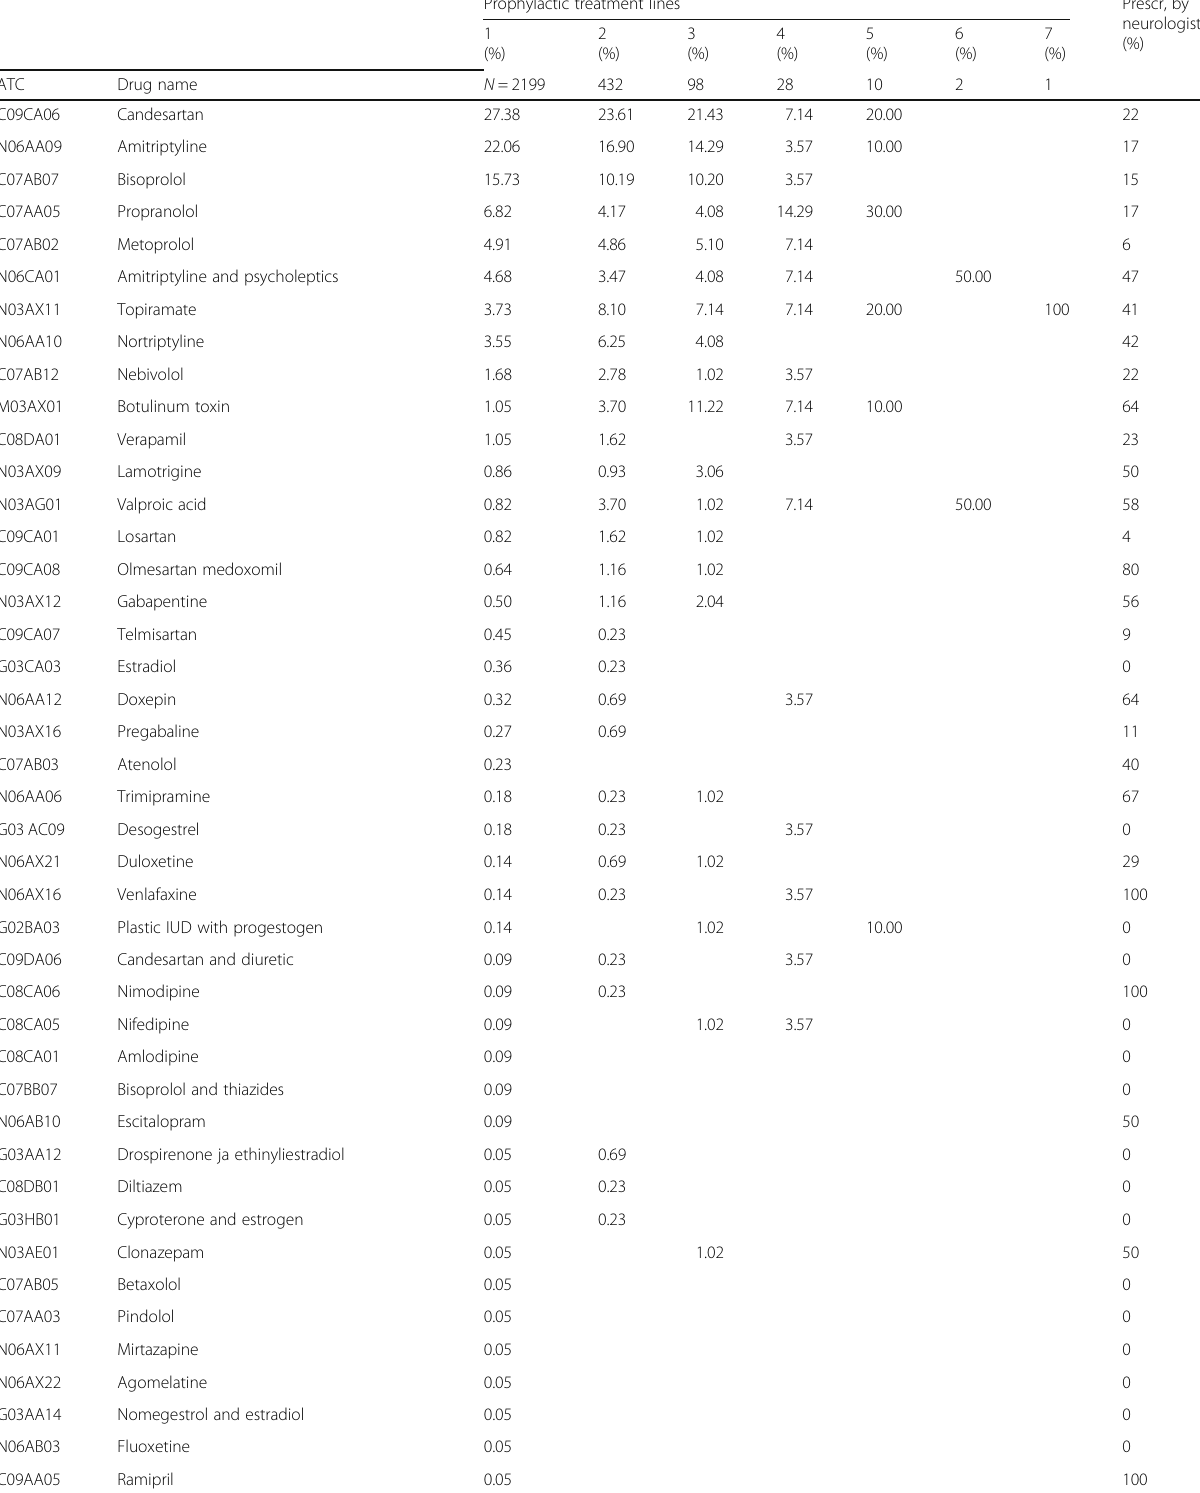
Table 3 Prophylactic treatment lines of patients with G43*diagnosis and the word migraine in the free text of a prophylactic migraine prescription. A new treatment line was defined as a new drug prescription Prophylactic treatment